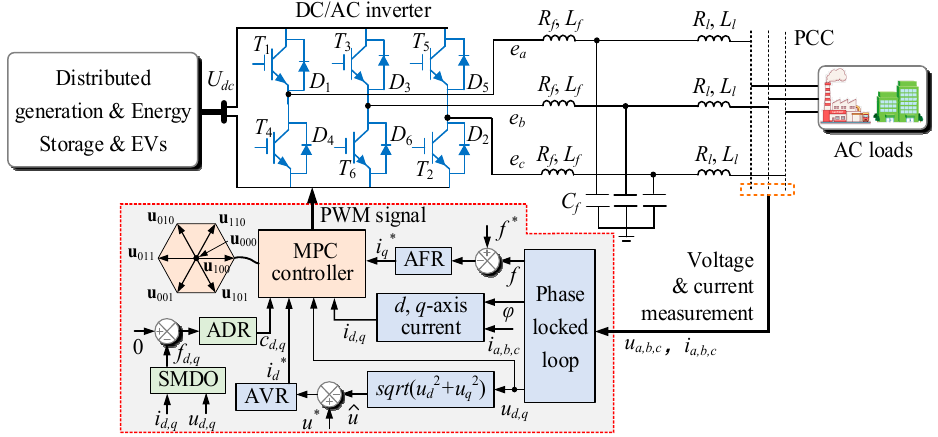
Figure 2. Structure of proposed DCL control strategy for microgrid working at island mode.